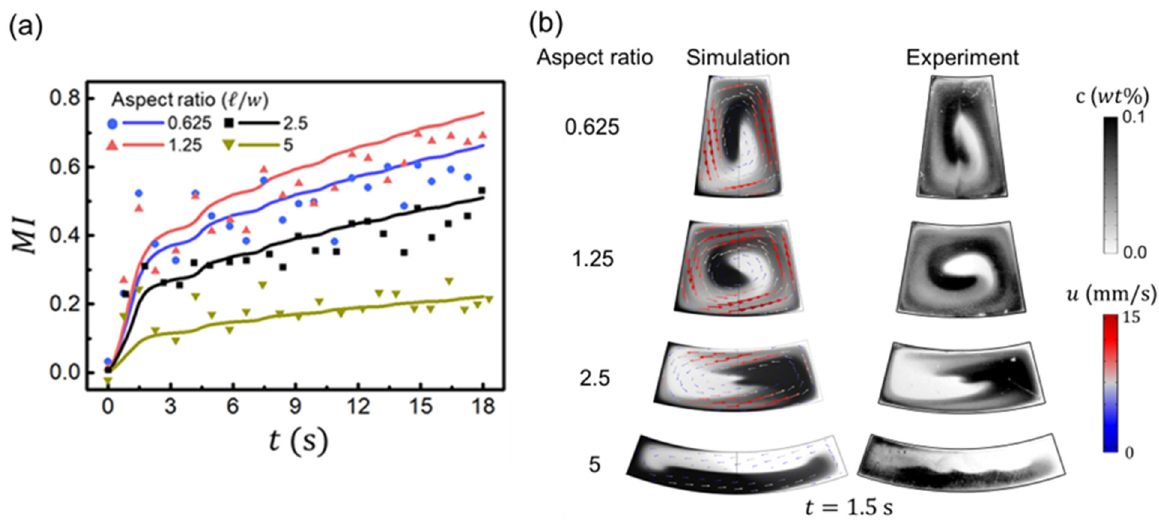
Figure 4. ( a ). Figure 4. ( a ) Mixing index of the concentration for the simulation (solid line) and experiment (dots), with time for various aspect ratios ( (cid:96) / w ) of the chamber. ( b ) Flow visualization of the chamber for both simulation and experiment at t = 1.5